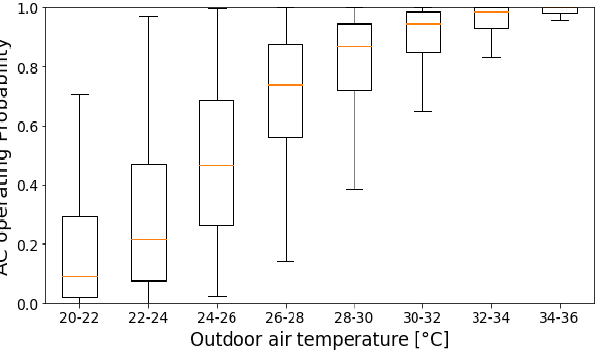
Figure 9. Boxplot of AC operating probability in different outdoor air temperature ranges [10].